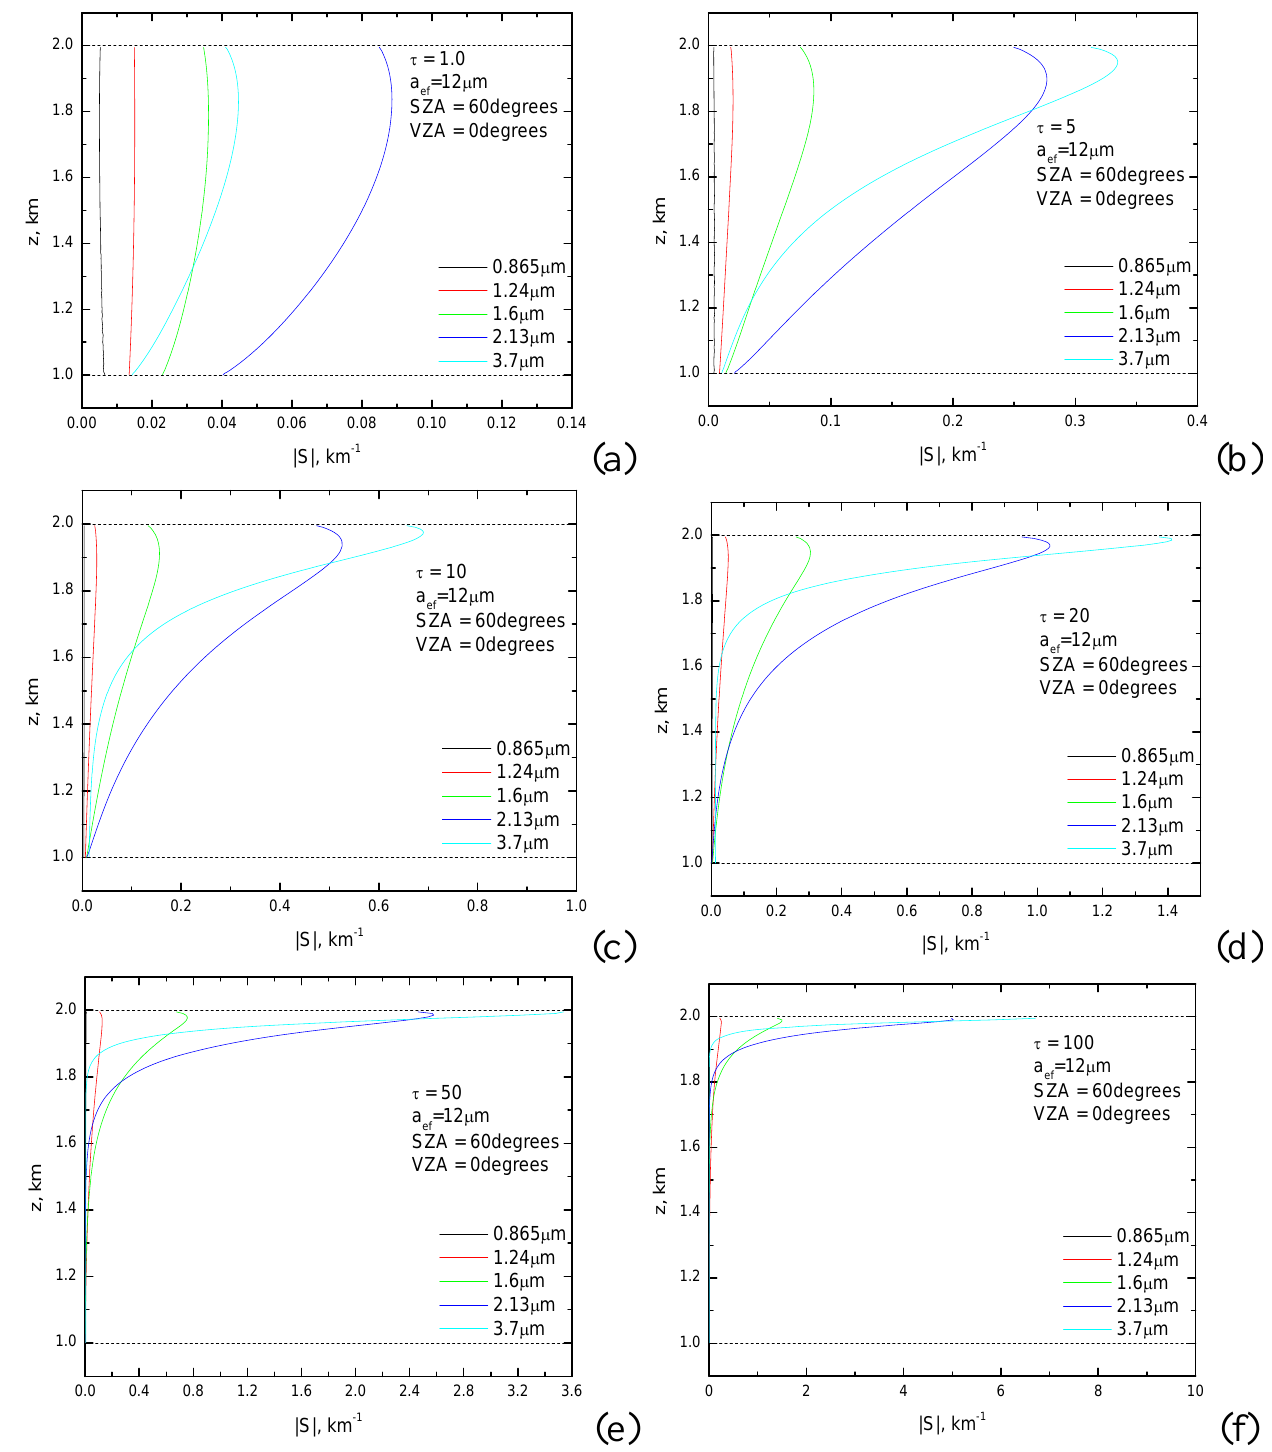
Fig. 1. The vertical profiles of the absolute value of S(z k ) for various wavelengths at COT=1 (a) , 5 (b) , 10 (c) , 20 (d) , 50 (e) , 100 (f) at a ef =12µm (VZA=0 degrees, SZA=60 degrees). The cloud is positioned between 1 and 2km. Rayleigh scattering and thermal emission are taken into account. Aerosol scattering and absorption is ignored.